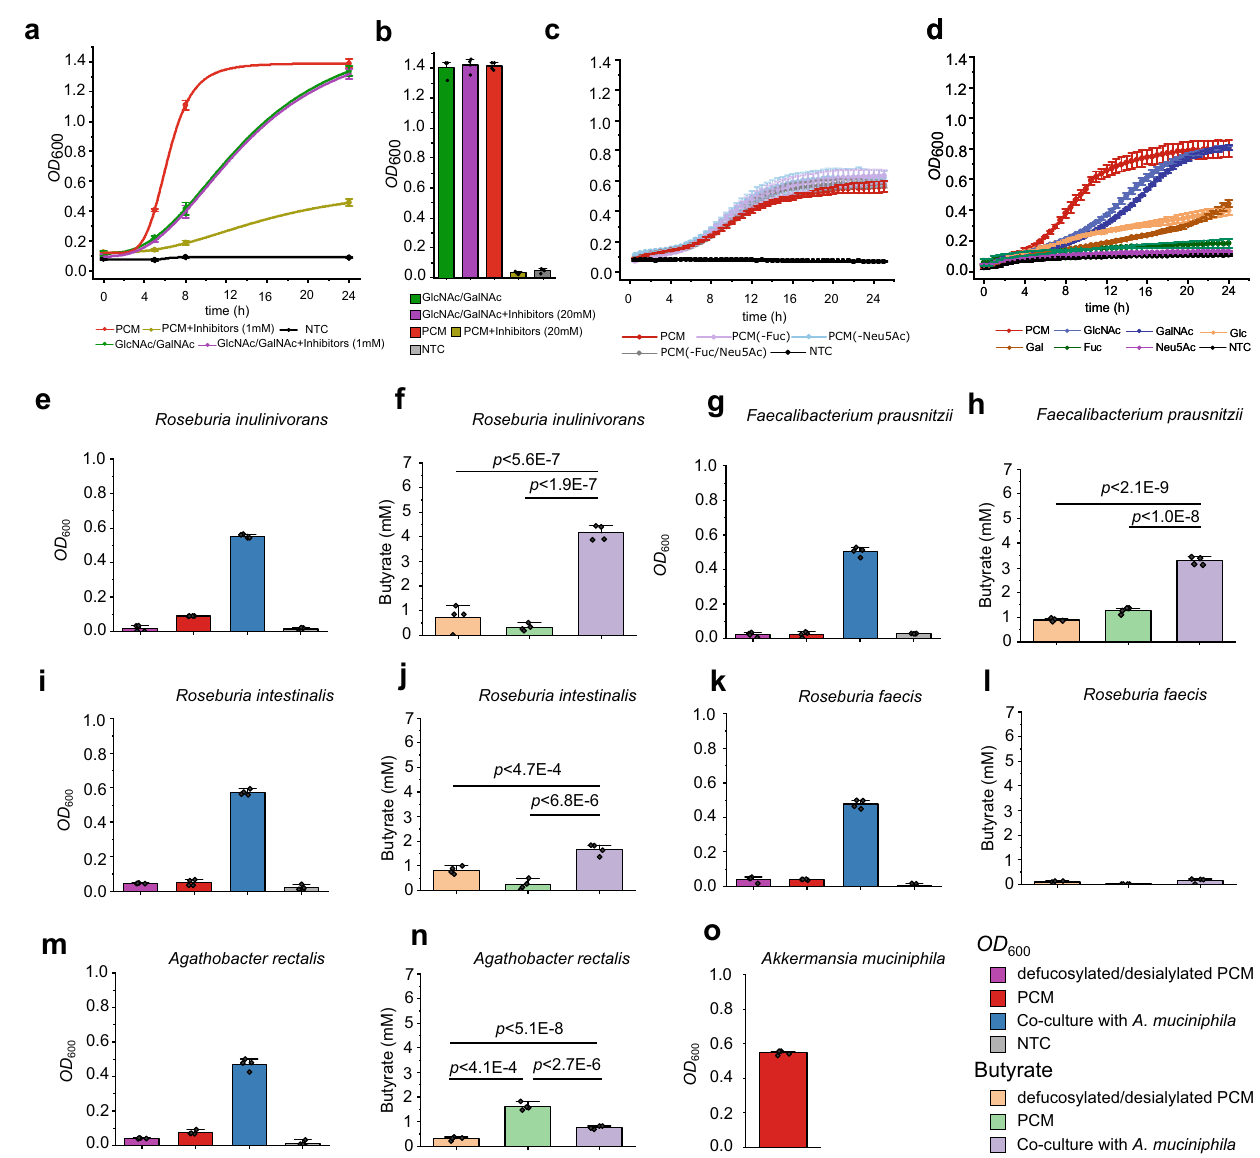
Fig. 4 | Fucosidases and sialidases of A. muciniphila are critical for growth on mucin and contribute to nutrient sharing with butyrate-producing Clostridia. a Growth curves of A. muciniphila on porcine colonic mucin (PCM) and on an equimolar mixture of GlcNAc/GalNAc, alone or in the presence of a equimolar mixture of fucosidase (DFJ, 1-Deoxyfuconojirimycin) and sialidase (DANA) inhibi- tors (1mM each) as compared to no-carbon source control (NTC). b Same as in a, but A.muciniphila growthisshownafter24hinthepresenceorabsenceof 20mM of each inhibitor. c Growth curves of A. muciniphila on PCM, de-fucosylated PCM and de-sialylated PCM compared to a no-carbon source control. The growth experiment was performed in a microtitre plate as opposed to panel a, where the growth ( OD 600 ) was measured in cuvettes. d Growth curves of A. muciniphila on monosaccharides from mucin and a no-carbon source control. e , g , i , k , m Growth levels of different butyrate producing Clostridia from the Oscillospiraceae and